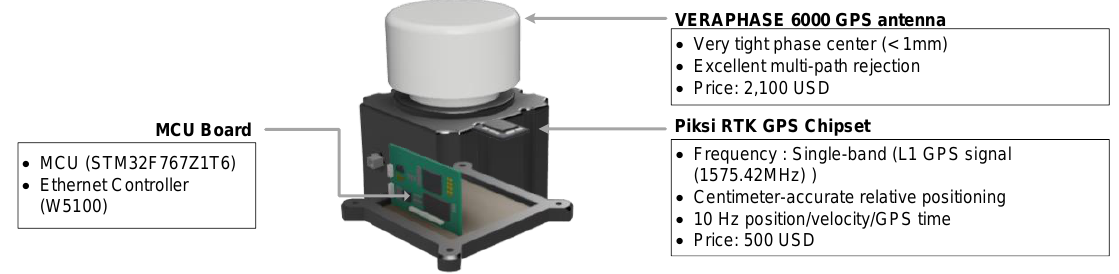
Figure 2. The base module composed of a GPS antenna and a GPS chipset.